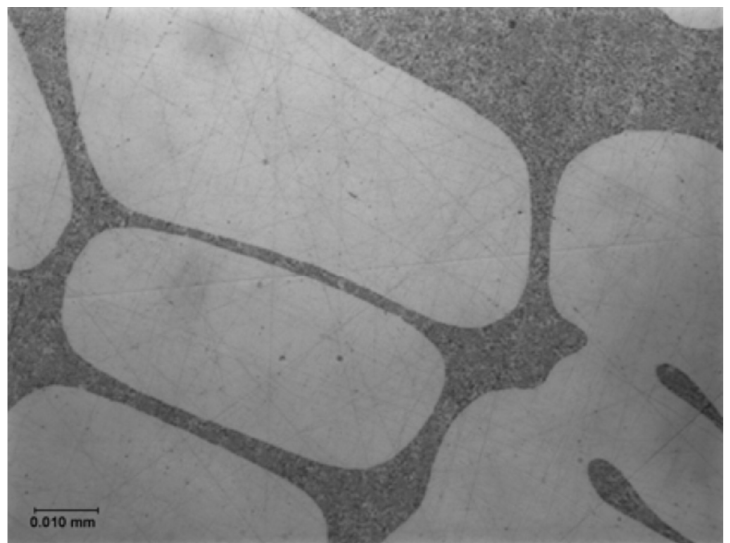
Figure 5. Ablation-modified Al–7wt.%Si with interdendritic classical coupled eutectic. Too fine to be resolved at 1000 × magnification (courtesy Alotech Inc., Cleveland, OH, USA).